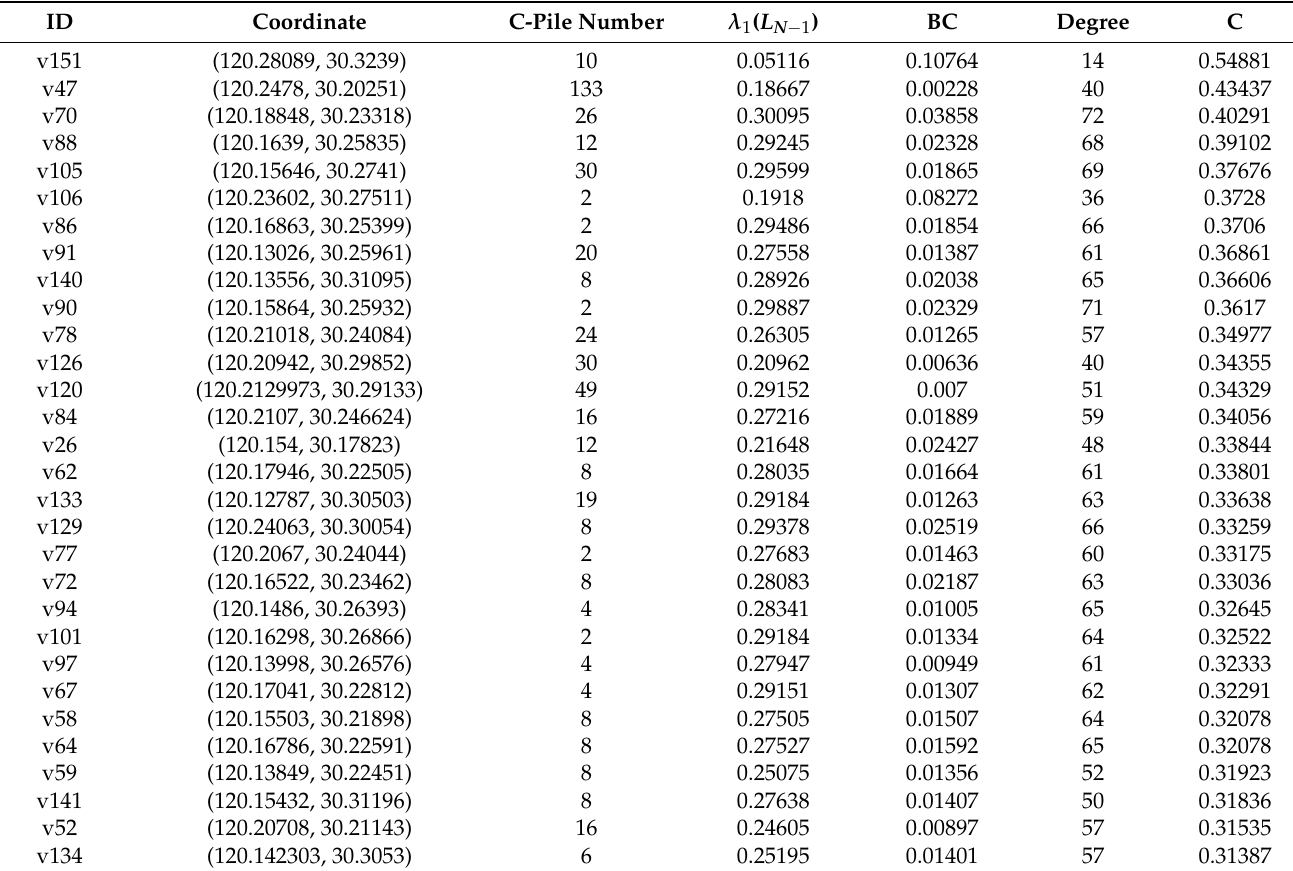
Table 1. Ranking of key nodes in HNSN (top